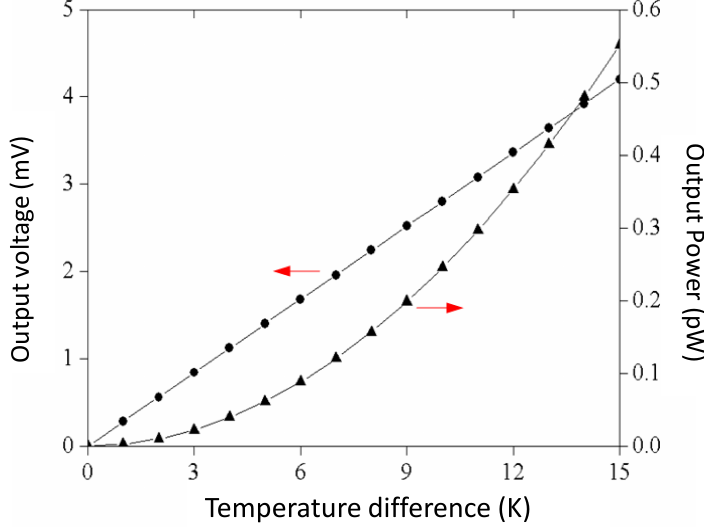
Figure 3. Simulated output voltage and power of the thermoelectric energy harvester.